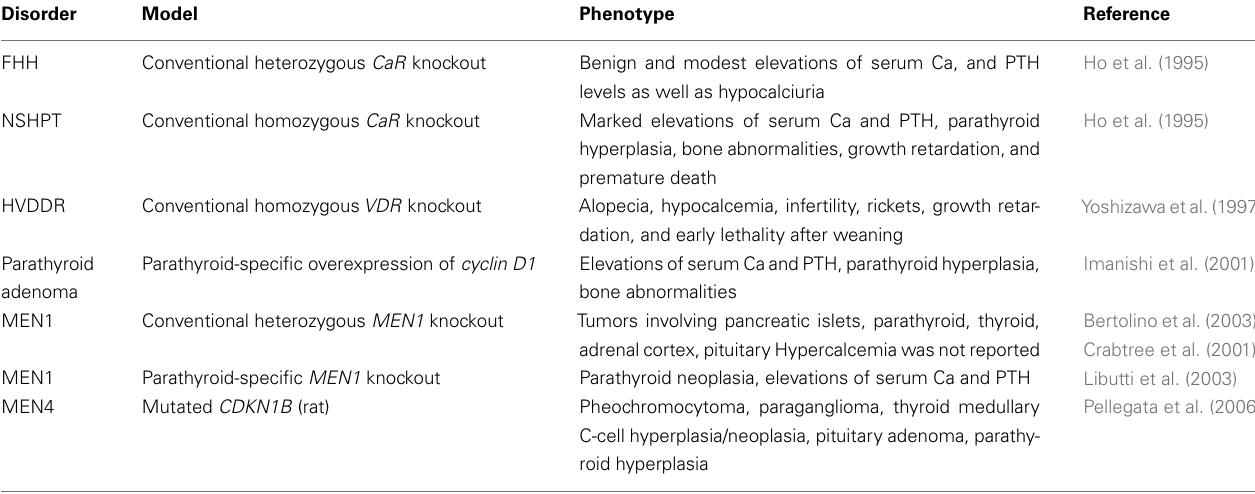
Table 1 | Mouse models for parathyroid